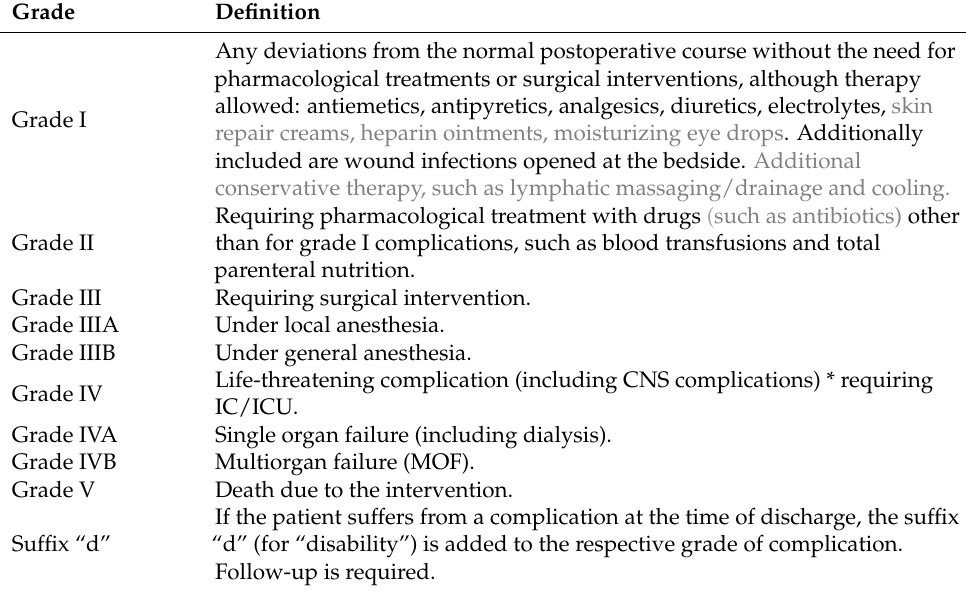
Table 1. Clavien–Dindo Classification § modified for Blepharoplasty (light grey